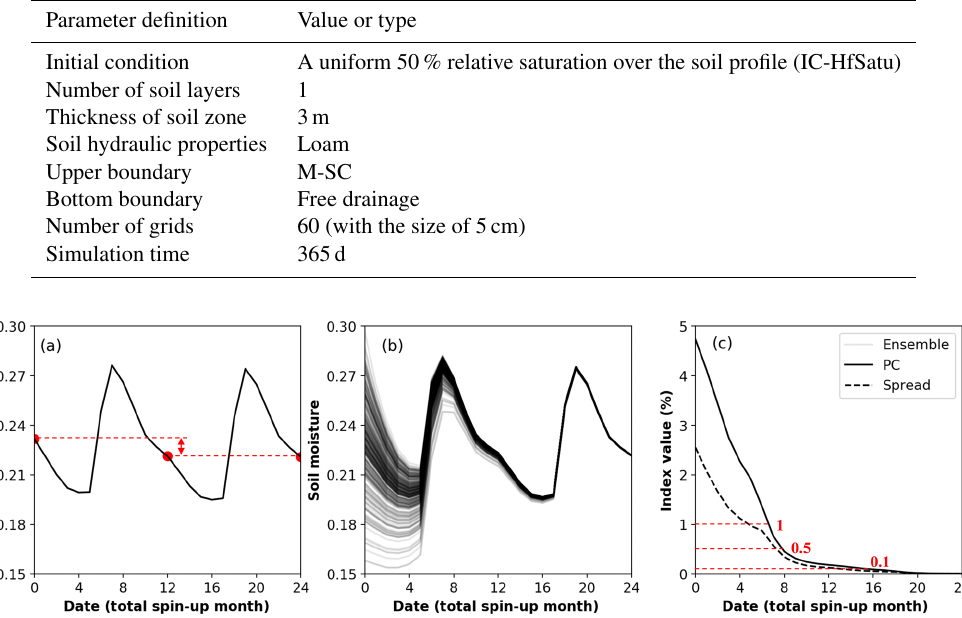
Figure 3. Comparison of spin-up and Monte Carlo methods in determining warm-up time. (a) The spin-up method with monthly averaged soil moisture versus time by running a simulation recursively for 10 years, (b) Monte Carlo method with monthly averaged soil moisture of different realizations versus time based on various initial conditions, and (c) comparison of PC and S p versus time. For the purpose of demonstration, the parameter uncertainty is not considered, and we only show the results of the first 2 years in the